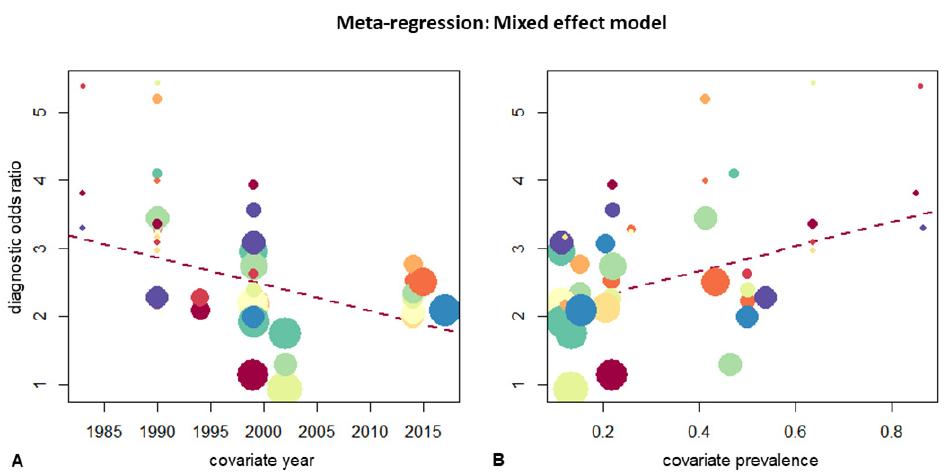
Figure 3. Mixed effect model for the moderator’s ( A ): “year” and ( B ): “empyema prevalence”. The dotted red line shows regression.